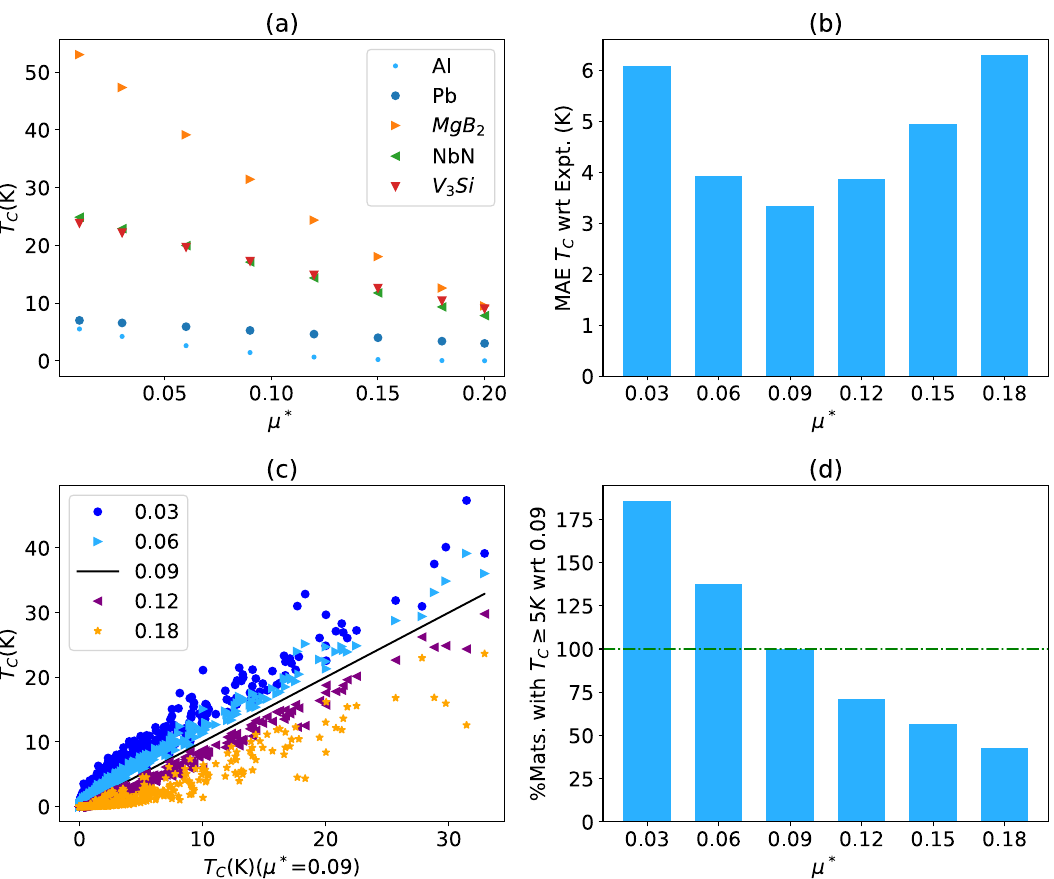
Fig. 4 Effect of μ * on transition temperatures. a Change in T C as we increase μ * for a few representative superconductors, b change in mean absolute error (MAE) with respect to experimental data with varying μ * suggesting an optimal value of 0.09, c change in T c with respect to μ * 0.09 for the entire dataset, d change in percenatge materials with T C greater equal to 5 K. Here μ * 0.09 is shown as 100%. As we decrease μ *, we add materials and